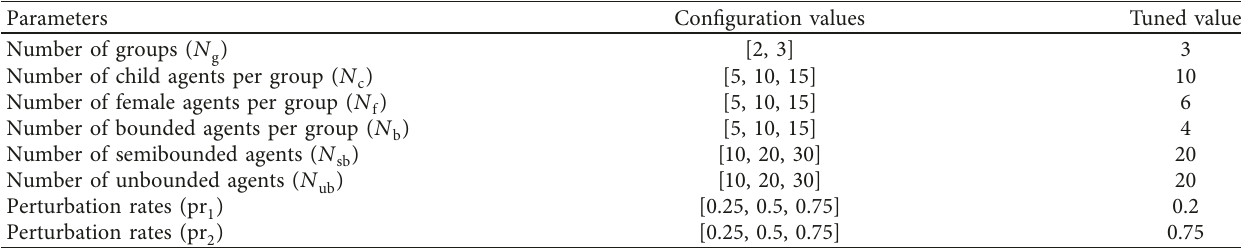
Table 1: SCEO checked configuration for